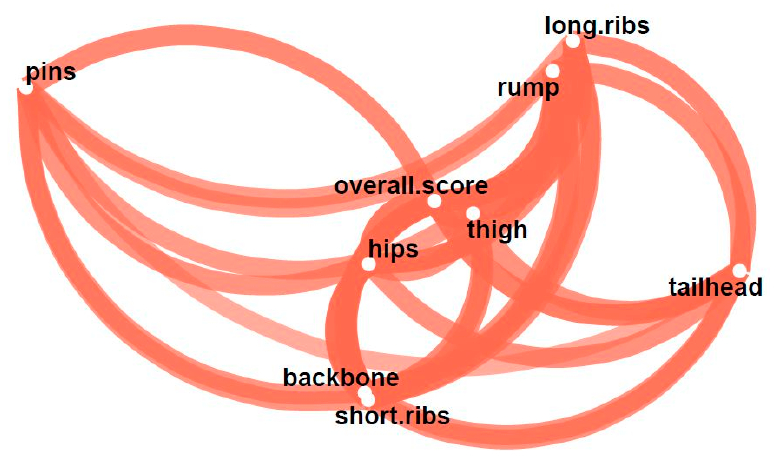
Figure 4. Score region cluster–network plot. The proximity of the score regions was determined using multidimensional clustering. The closer each characteristic is to each other, the higher the relationship, regardless of assessors’ backgrounds. Line thickness shows the correlation with the mean score value. All correlations were positive.